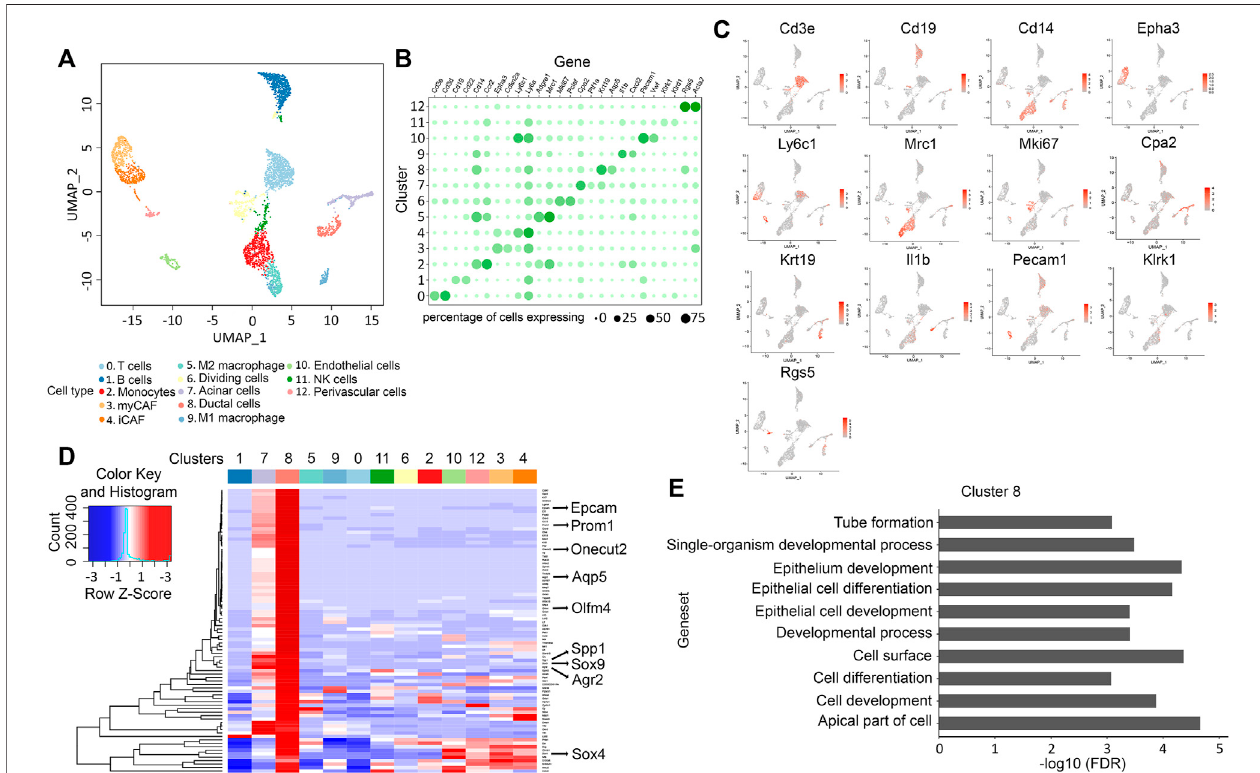
FIGURE 3 | scRNA-Seq analysis reveals a progenitor-like ducts for the ductal hyperplasia in KNGC mice. (A) UMAP plot of 4,705 cells, colored by cell type identi fi edbyclustermarkers. (B) Geneexpressiondotplotshowingselectedcluster-speci fi cgenes.Rowsareclustersandcolumnsaregenes.Sizeofthedotsindicates percentage of cells expressing a gene in each cluster. Color depth of the dot indicates normalized expression value. (C) UMAP plot of 4,705 cells colored by expression of selected genes from (B) . (D) Heatmap showing average expression of selected genes with log foldchange over 1 (lfc > 1) across all clusters. (E) Top over- represented pathways for marker genes of cluster